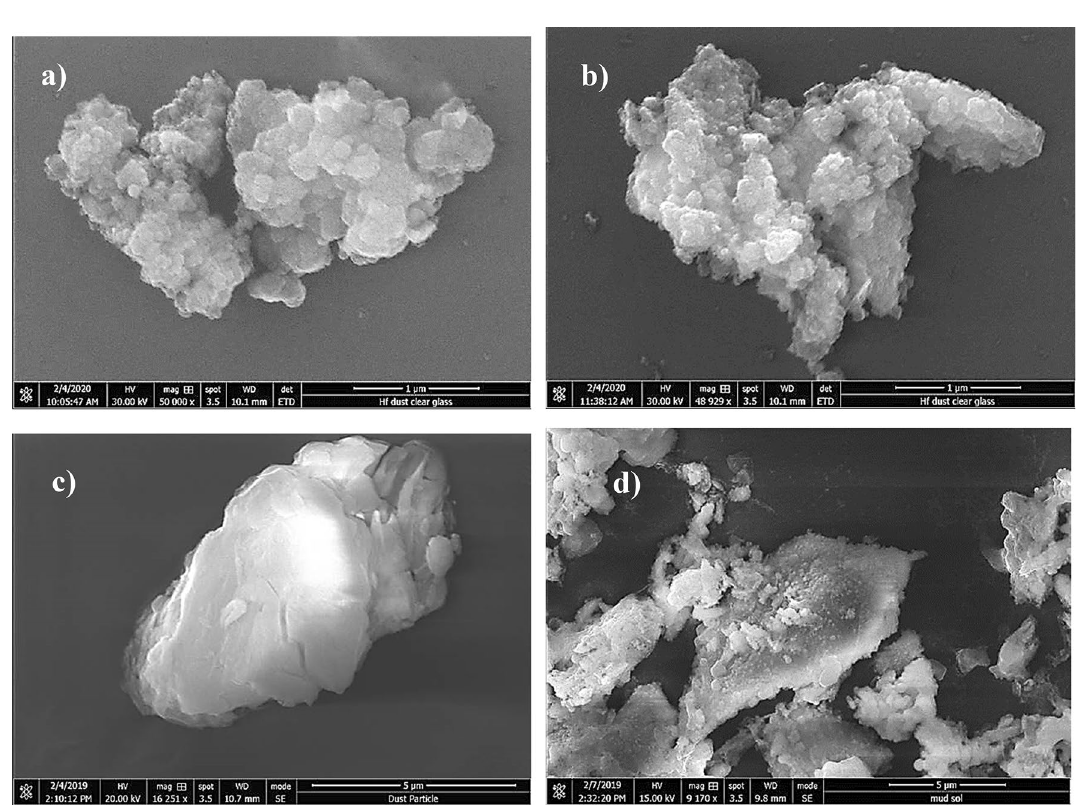
Figure 4. SEM images of solution cured dust particles: ( a ) grafted dust surface, ( b ) sub-micro holes on dust surface, ( c ) sub-micro crack on dust surface, and ( d ) interlocked dust